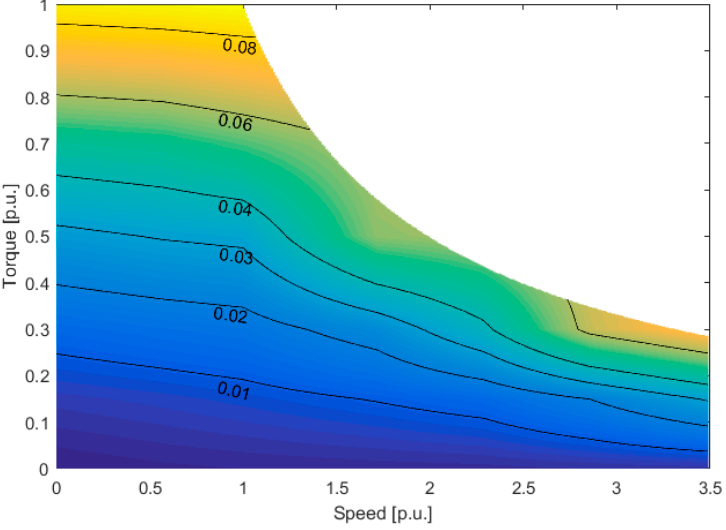
Figure 4. Electric drive losses in per unit (p.u).